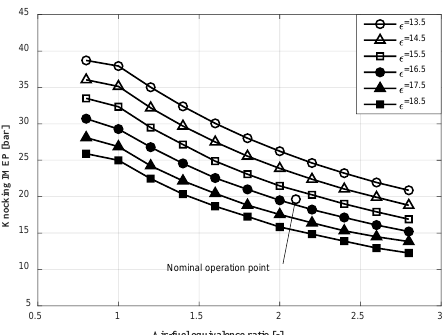
Figure 9. Knocking IMEP variation with air – fuel equivalence ratio under different compression ratios (Engine B).